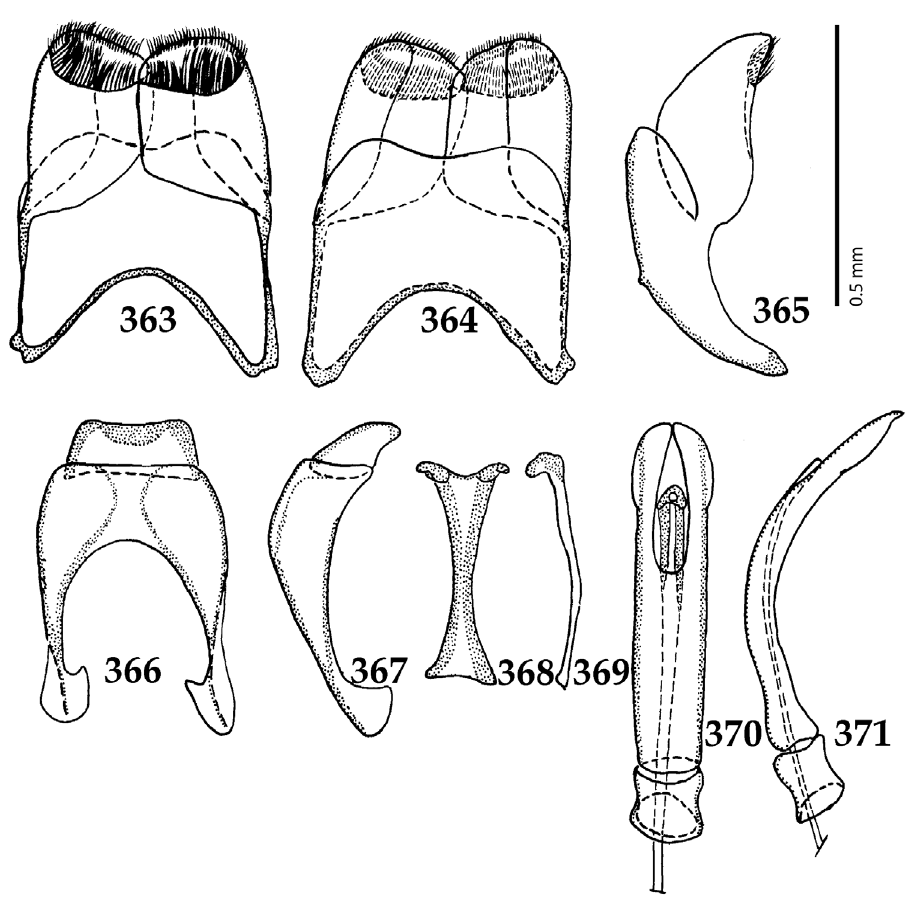
Figures 363–371. 363 Saprinus ( Saprinus ) chalcites (Illiger, 1807) male terminalia: 8 th sternite + 8 th tergite, ventral view 364 ditto, dorsal view 365 ditto, lateral view 366 male terminalia: 9 th + 10 th tergites, dorsal view 367 ditto, lateral view 368 male terminalia: spiculum gastrale, ventral view 369 ditto, lateral view 370 male terminalia: aedeagus, dorsal view 371 ditto, lateral